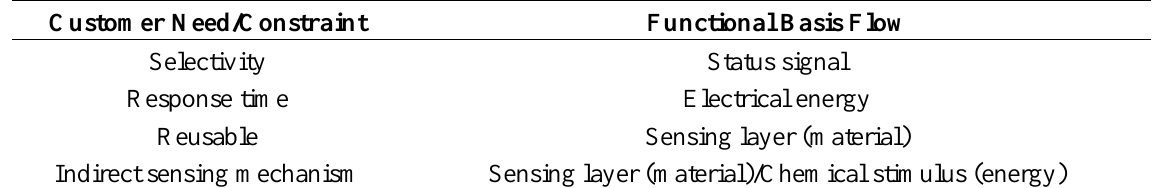
Table 2. Chemical sensing needs mapped to conceptual